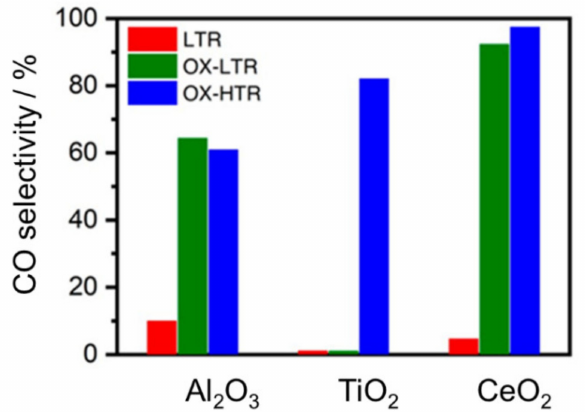
Figure 7. Selectivity of CO 2 reduction over oxide supported Ru catalysts (powder form) toward CO formation in CO 2 /H 2 gas mixture at 240 ◦ C upon exposure to different treatments ( LTR : exposure to 5% H 2 /Ar at 230 ◦ C for 30 min; OX-LTR : oxidation in 5% O 2 /Ar at 230 ◦ C for 30 min, then 5% H 2 /Ar at 230 ◦ C for 30 min; OX-HTR : oxidation in 5% O 2 /Ar at 230 ◦ C for 30 min, then 5% H 2 /Ar at 530 ◦ C for 30 min). All catalytic measurements were carried out at a constant GHSV using a layer of 20 mg of catalyst powder diluted (1:10) catalytically inactive Al 2 O 3 , sandwiched between two layers of granular acid-washed quartz (reprinted from Ref [59] © 2018, American Chemical Society Inc, Washington, DC,